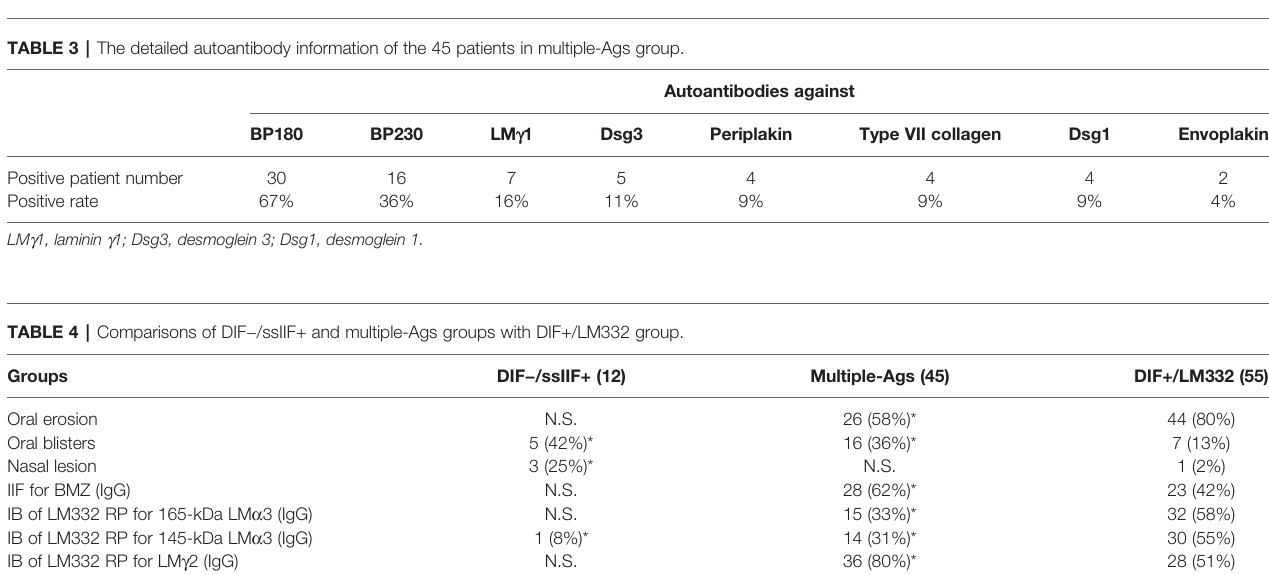
( Table 5 ). Compared with the DIF+/ssIIF − group, the DIF − /ssIIF+